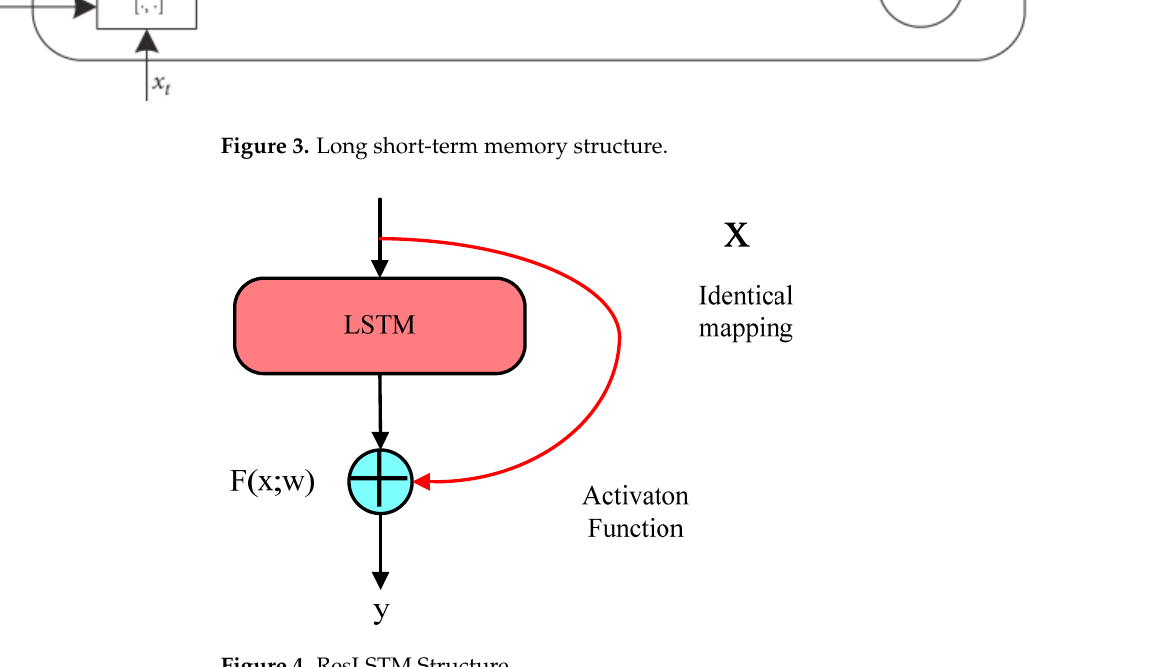
Figure 4. ResLSTM Figure 4. ResLSTM Structure.